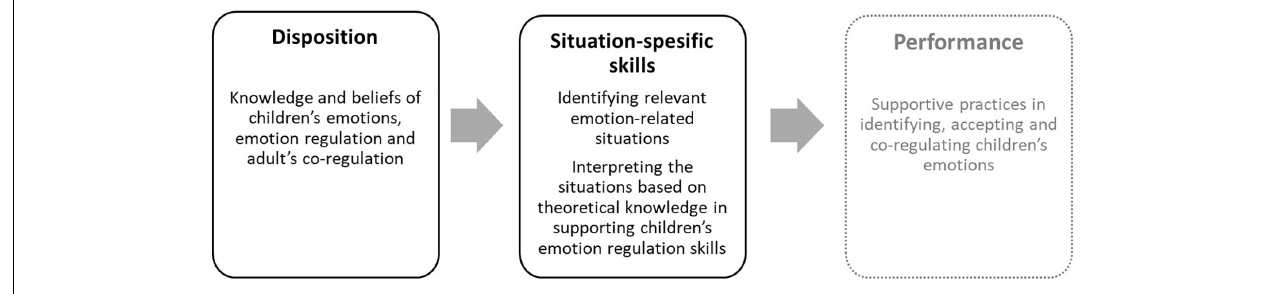
FIGURE 5 | Rationale behind capturing ECEC professionals’ learning in terms of (co-)regulation of emotions. Edited based on the model of competence as a continuum (Meschede et al.,